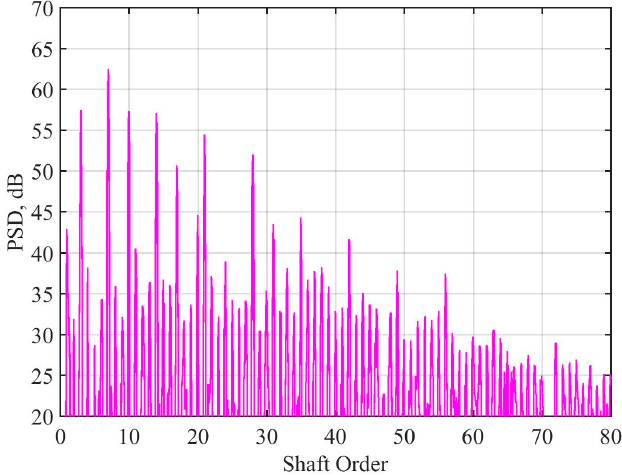
Figure 8. Tone noise spectrum from mini-rotor model acoustic data, computed using the modified algorithm.